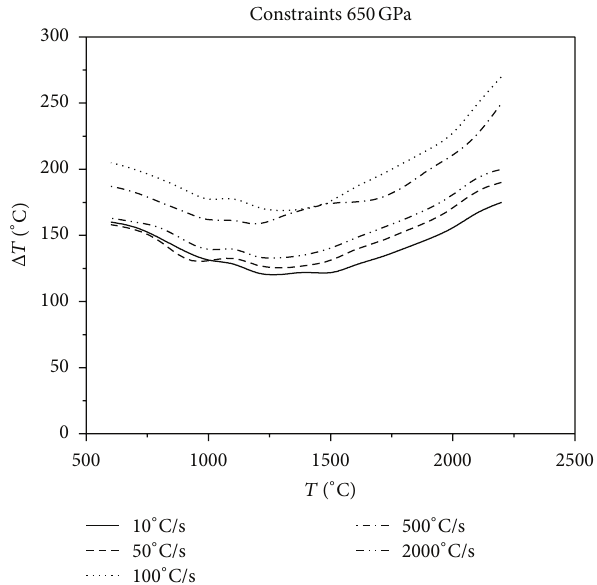
Figure 13: Relationship between critical fracture temperatures corresponding to different cooling rates and thermal shock initial temperatures under the constraints of 650